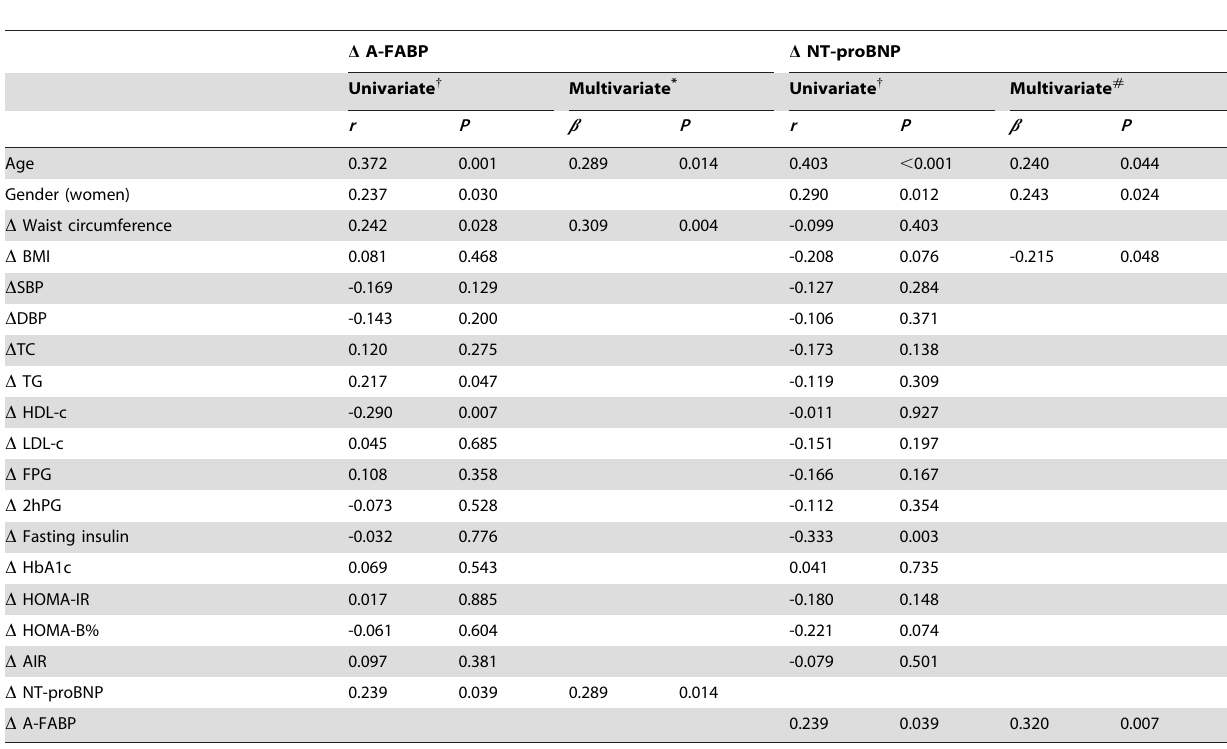
Table 4. Changes in anthropometric and biochemical parameters showing significant correlations with changes in serum A-FABP and NT-proBNP during the 48-week rosiglitazone